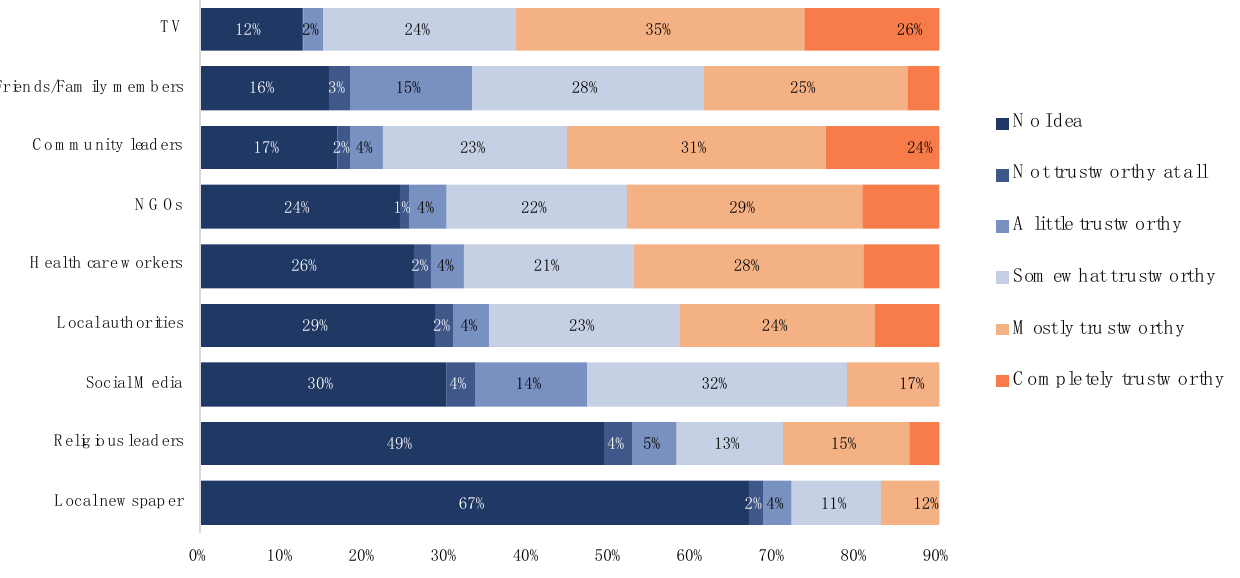
Figure 3. Marginalized people’s digital competence ( n = 220).